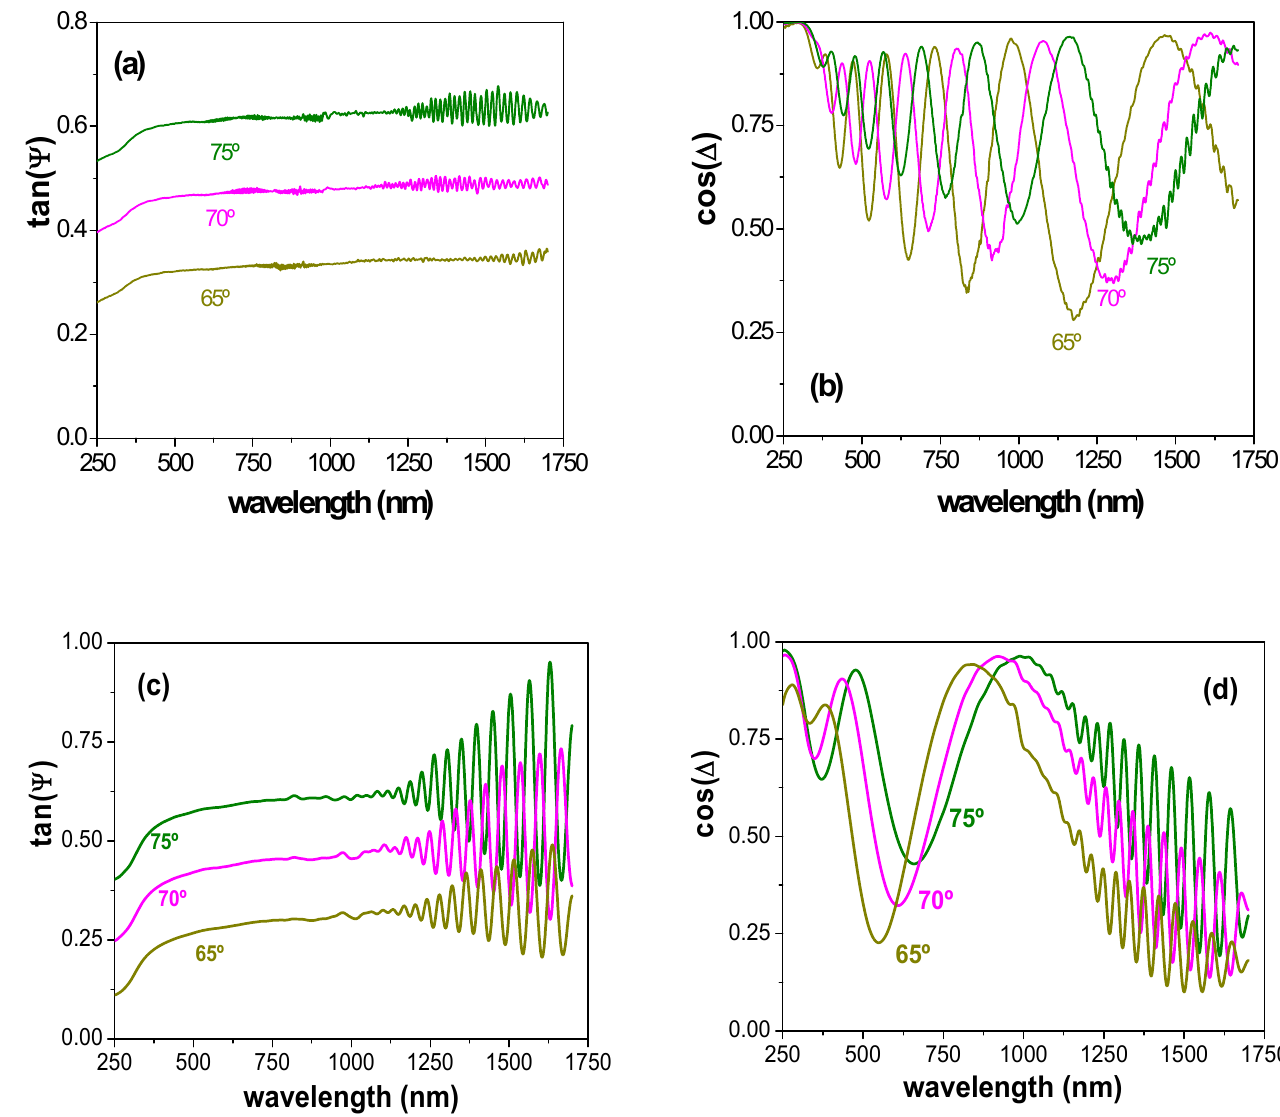
Figure 3. Wavelength dependence for tan(Ψ ) and cos(∆) at three light incident angles: 65° (dark yellow lines), 70° (magenta lines), and 75° (green lines). ( a , b ): Ox(A)/SiO 2 sample; ( c , d ): Ox(B)/SiO 2 sample.